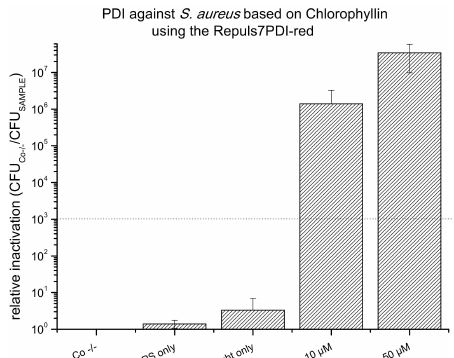
Figure 7. Photodynamic Inactivation of S. aureus shown as relative inactivation (CFU Co − / − / CFU sample ). Chlorophyllin was photoactivated using the Repuls7PDI-red (radiant exposure: 25.6 J · cm − 2 , irradiance: 26.3 mW · cm − 2 ). The bars represent the average of three independent biological replicates including the standard deviations as error bars. The black dashed line corresponds to a reduction of 3 log 10 (99.9% killing e ffi cacy). Three controls were included in this experiment. Co − / − : double negative control; PS only: dark control; and light only: light control. The black dashed line corresponds to a reduction of 3 log 10 units as the criterion for an antibacterial e ff